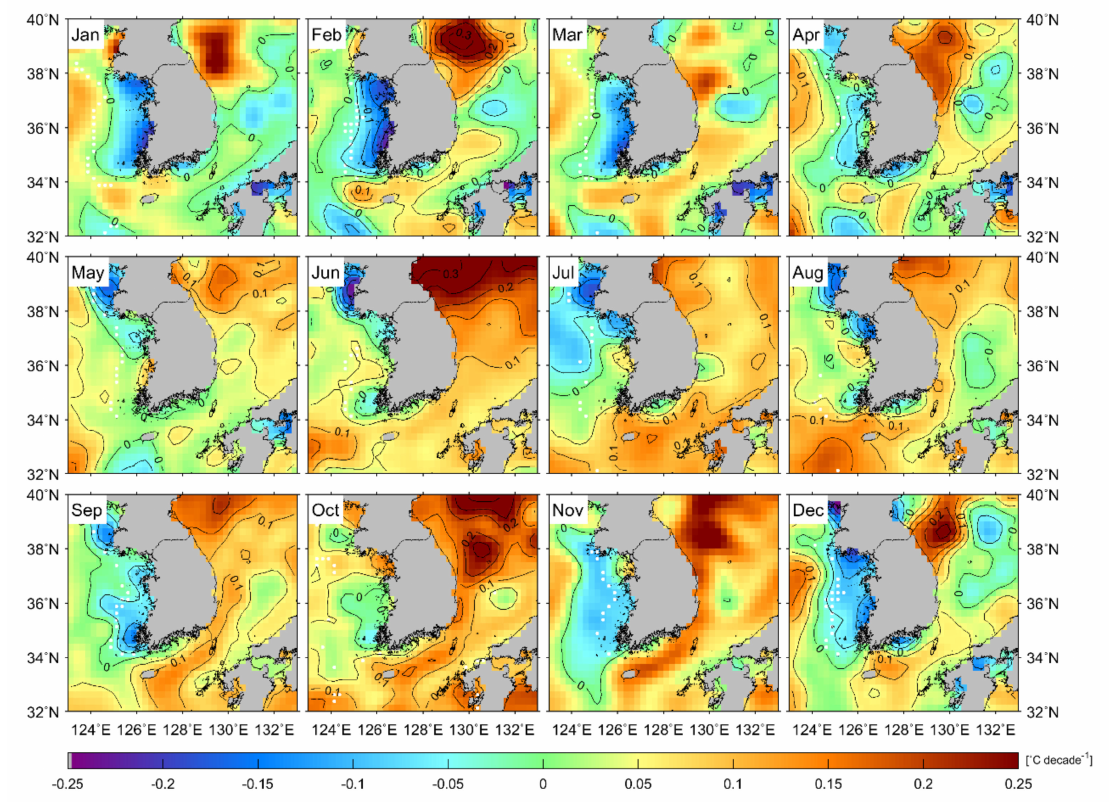
Figure 9. Monthly distribution of SST trends ( ◦ C decade − 1 ) for 1982 to 2018 from the OISST data, where a white dot represents a pixel of statistically insignificant trend within the 95% confidence